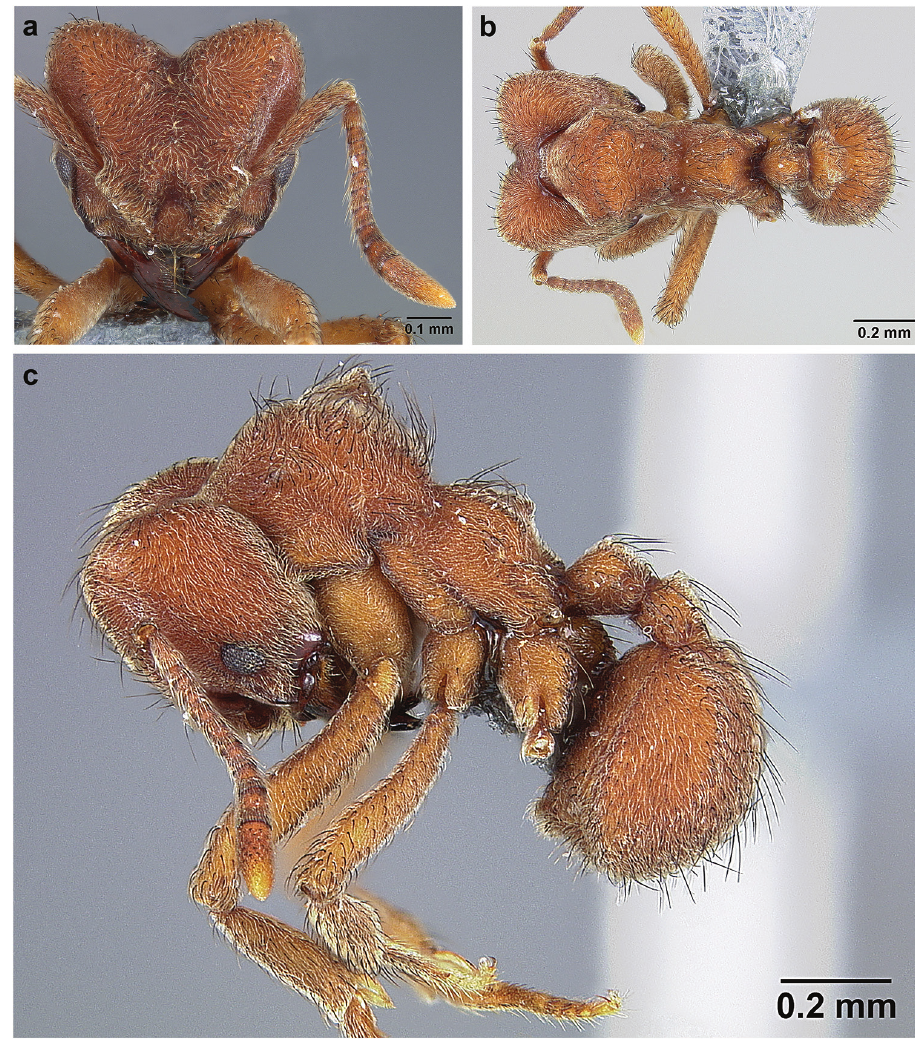
Figure 22. S. bondari worker (USNMENT01125207). a Head b dorsal view; and c lateral profile. short and thin supraocular carinae present, never reaching posterior cephalic corner (Figure 8c). Eye large (OI=20 ± 1) and convex, 17–21 ommatidia across largest diam- eter. Frontal lobe wider than in worker (FLI=73 ± 3), antennal scape as in worker, not reaching posterior cephalic corner. Mesosoma. Lateral pronotal tubercles distinct. Scutum in dorsal view with notauli faint, sometimes absent. Median mesoscutal line sometimes anteriorly developed into weak costa, posteriorly with shallow longitudinal impressions on each side. Parapsidal lines thin, slightly curved. Scutellum inflated, short in dorsal view, narrowing